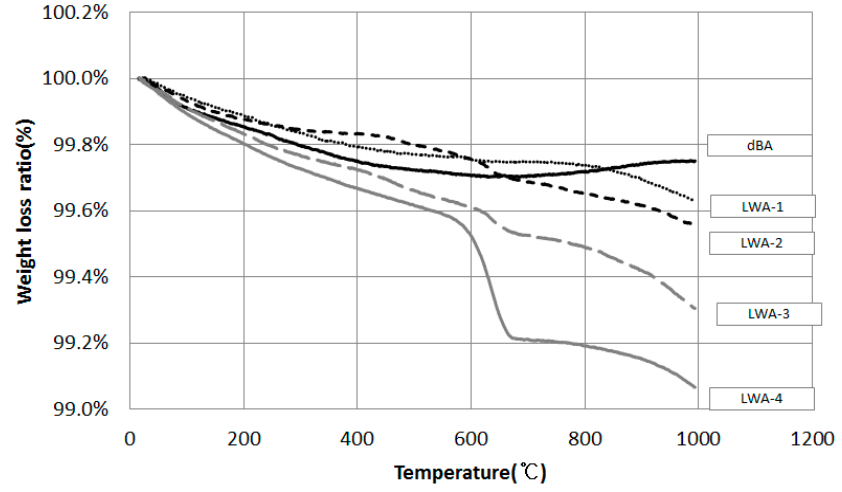
Figure 13. DT-TGA of coal ash and LWA.